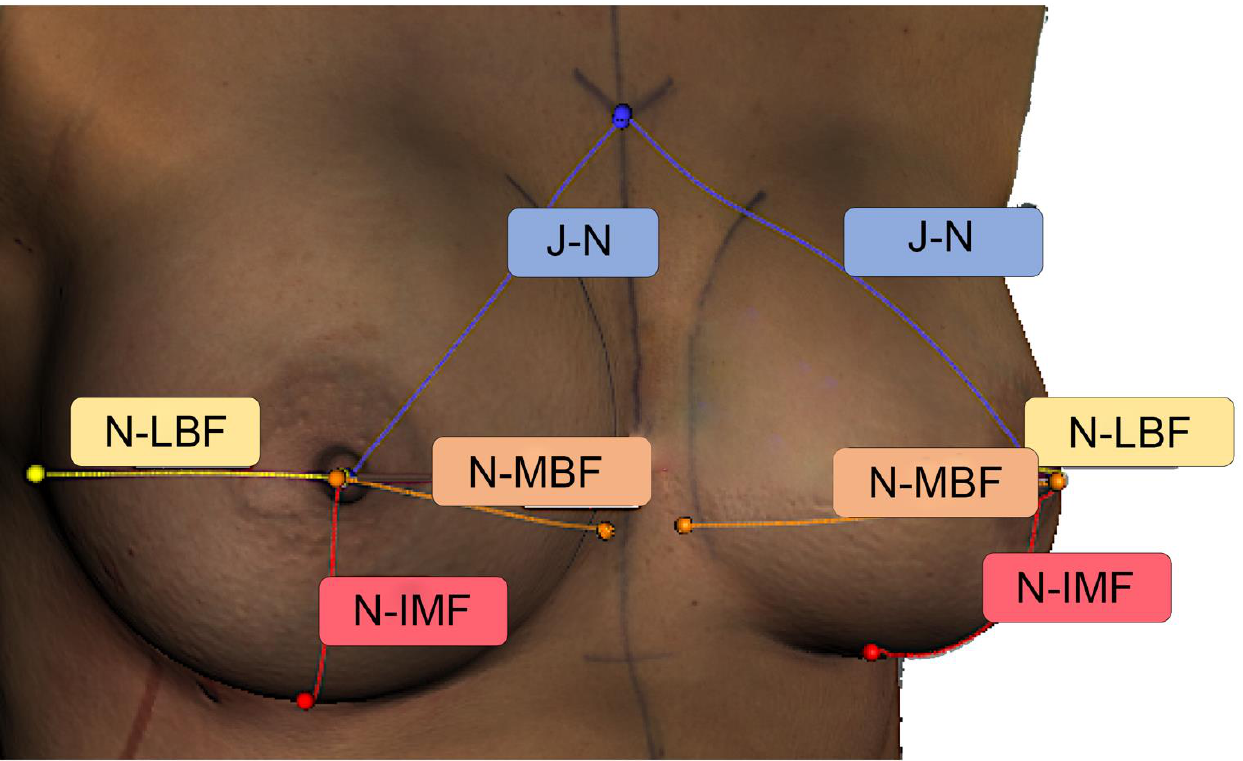
Figure 2. Anthropometric measurements in an intraoperative 3D scan using the Artec Studio 12 software (Artec, Luxembourg). Here we provide an example of 3D measurements of the breast. N-LBF = nipple — lateral breast fold distance, N- IMF = nipple — inframammary fold distance, N-MBF = nipple – medial breast fold distance, J-N = jugulum — nipple distance. Distances are indicated in millimeters with matching colors.